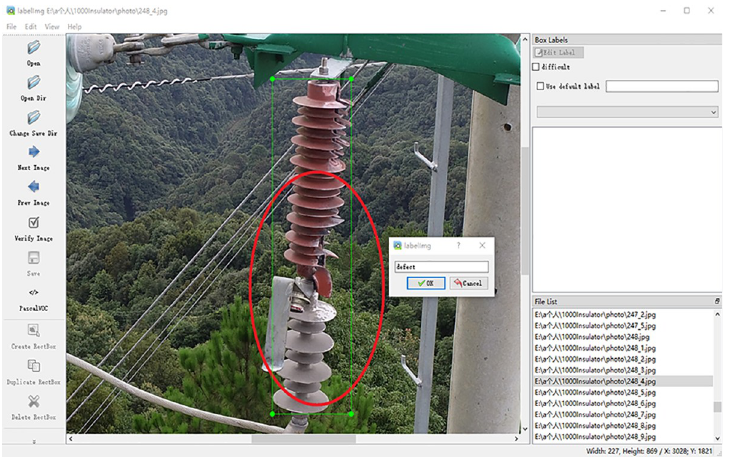
Fig 8. The labeling diagram of